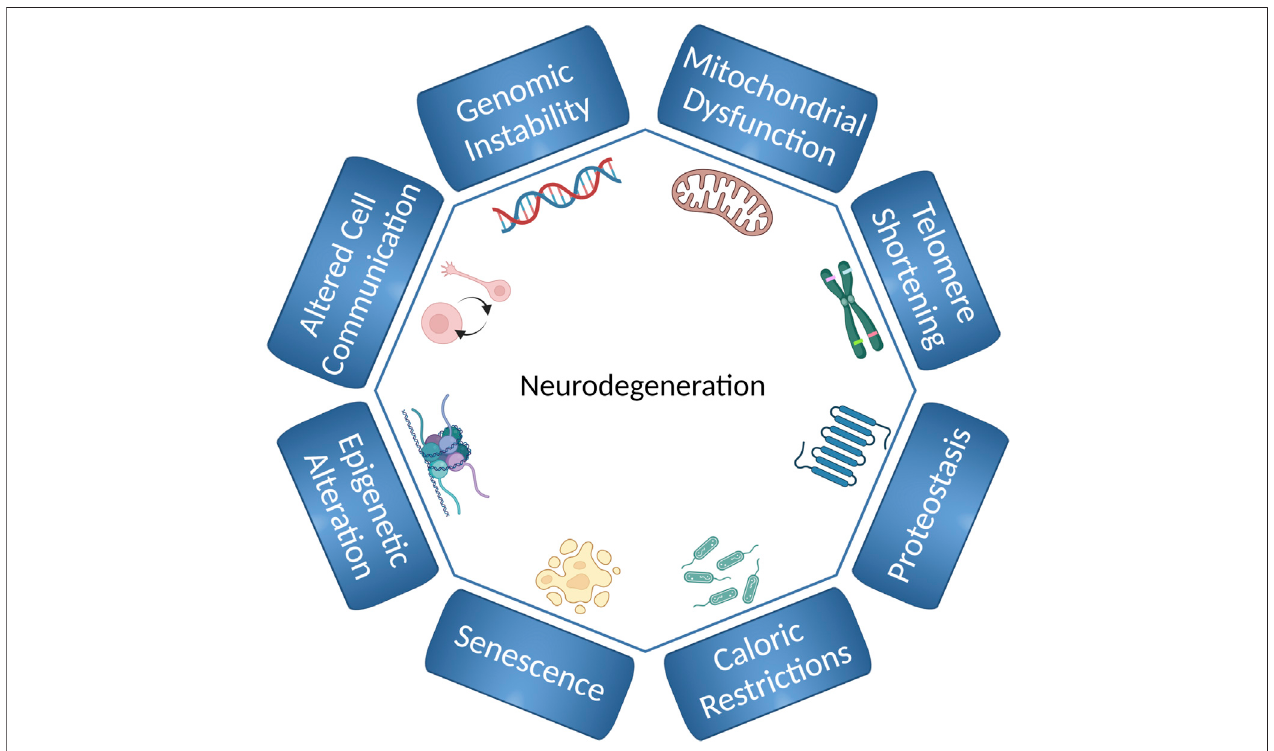
FIGURE 1 | Hallmarks of aging and neurodegeneration in C. elegans . The hallmarks of aging and neurodegeneration in C. elegans include genomic instability, telomere shortening, epigenetic alterations, loss of proteostasis, deregulated nutrient-sensing, mitochondrial dysfunction, cellular senescence, and altered cell communication. The fi gure has been generated using Biorender.com by the